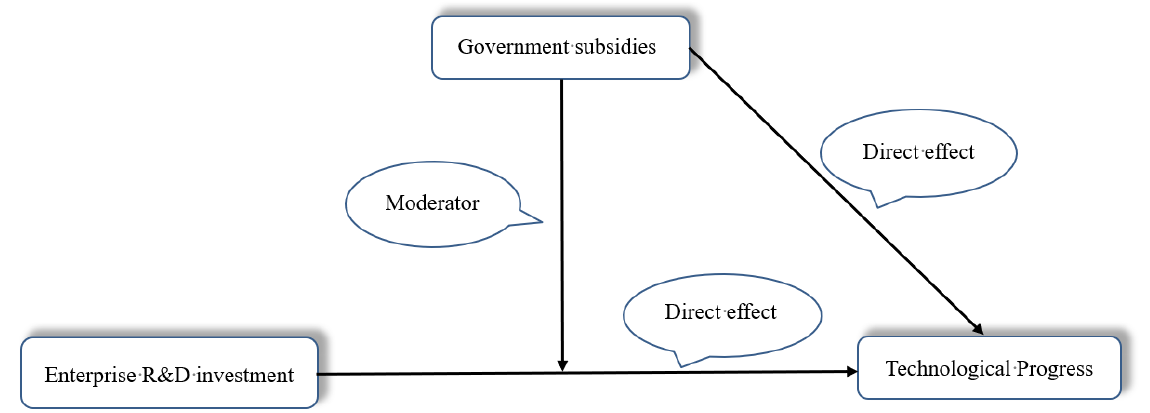
Figure 4. Hypothetical conceptual model. (Source: Created by authors).